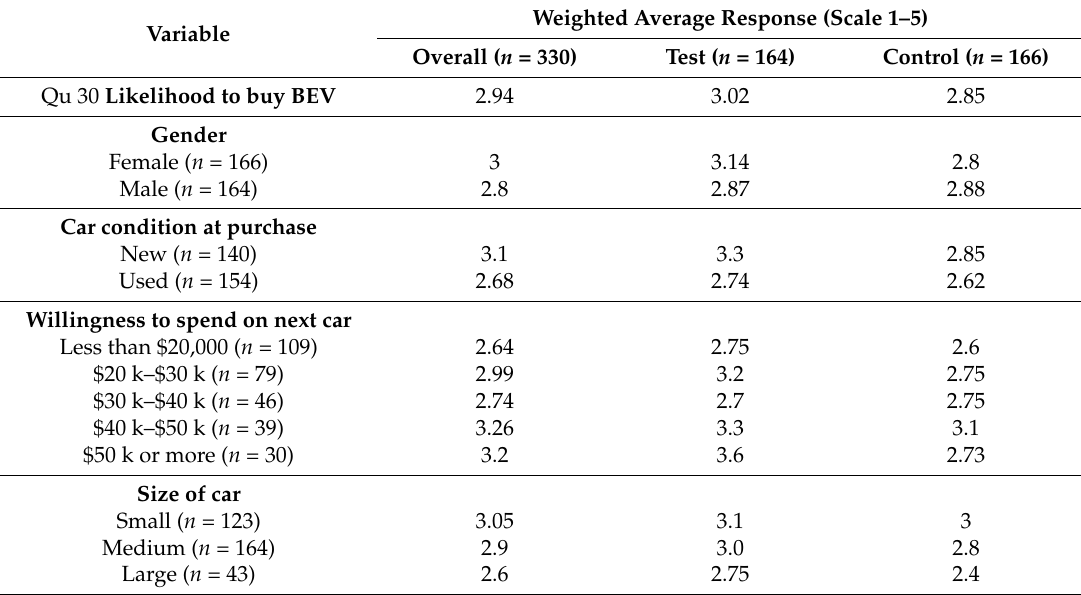
Table 3. Likelihood of buying a BEV or PHEV, and variables for Test and Control